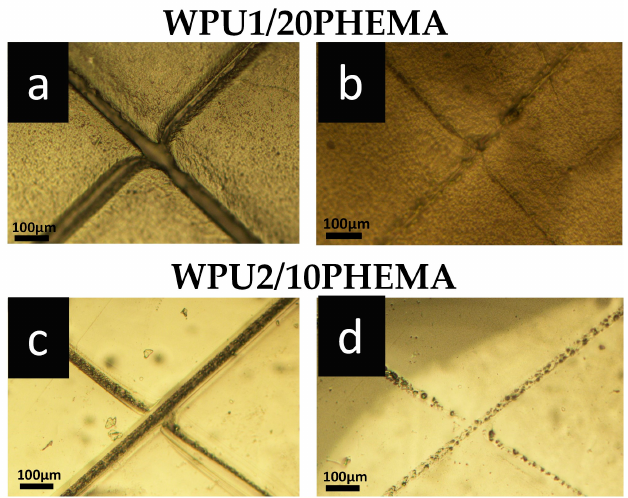
Figure 7. Optical microscopy photographs of ( a,b ) WPU1/20PHEMA ( c,d ) WPU2/10PHEMA films: